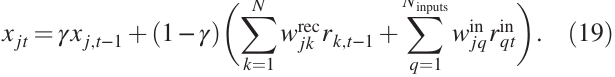
Figure 4(c) repeats the same analysis for NP with η varied from 0 . 05 · η (cid:2) to η (cid:2) . Gray curves in Fig. 4(c) (NPc with η NP NP adjusted by a factor of 0 . 5 ; 0 . 6 ; … , 1.2) use 100